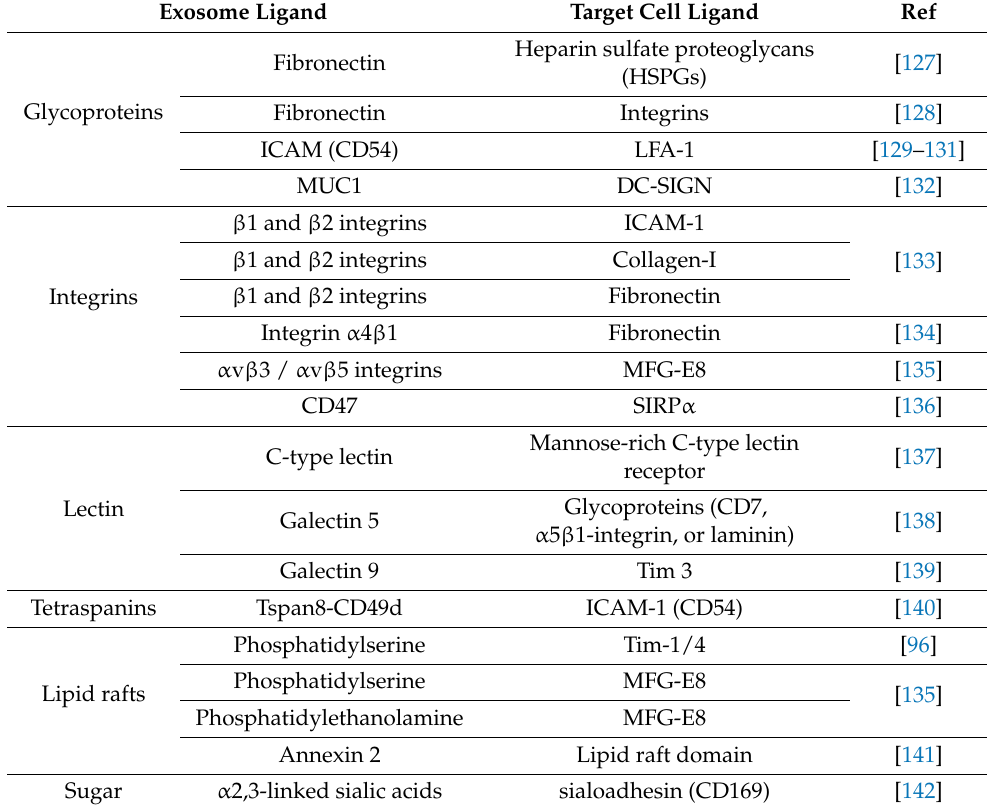
Table 3. Summary of ligand–receptor interaction in exosomes/cell